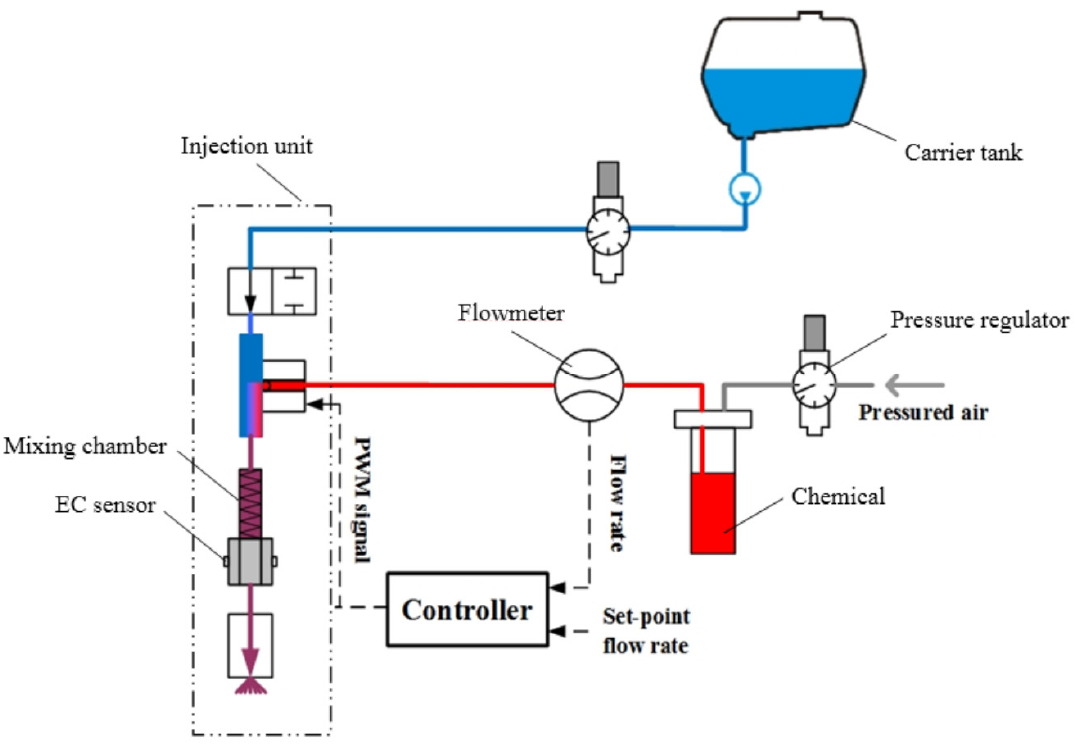
Figure 3. Setup for controlling pesticide injection rate by closed-loop method.